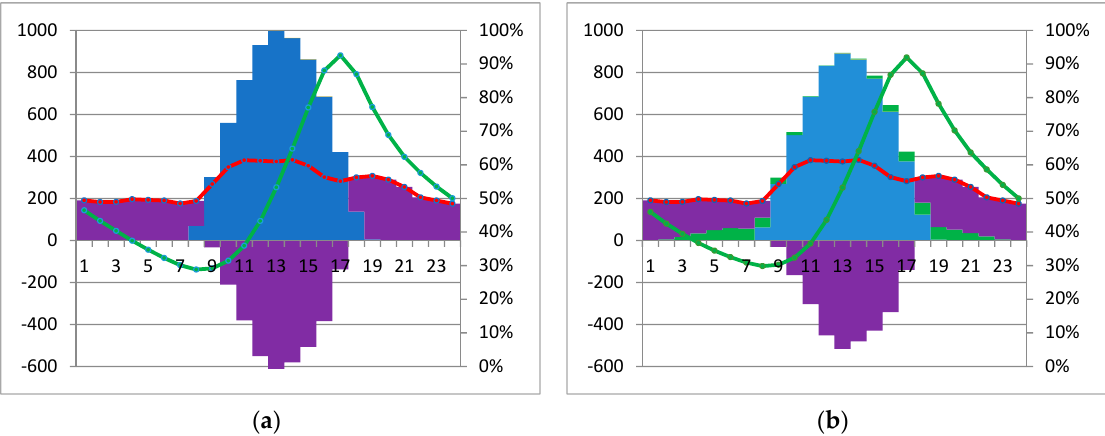
Figure 5. Day 1, 25/02/2009: Energy balance ( a ) without and ( b ) with tidal energy. Figure 5. Day 1, 25 / 02 / 2009: Energy balance ( a ) without and ( b ) with tidal